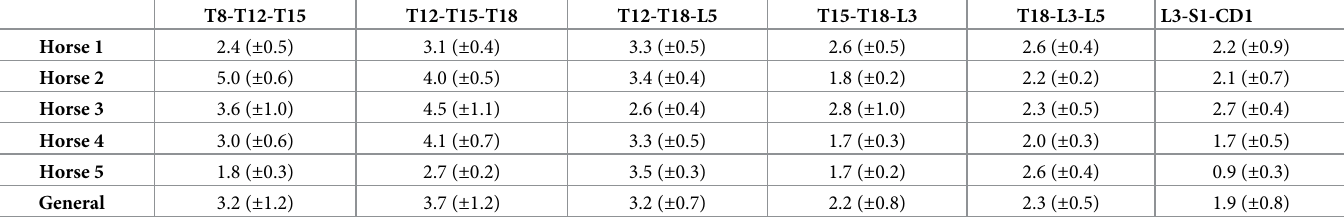
Table 2. Mean ( ± standard deviation) range of motion (ROM) in degrees ( ⁰ ) of individual horses and all horses (General) at different angles analyzed in the sagittal plane (plane X-Y).